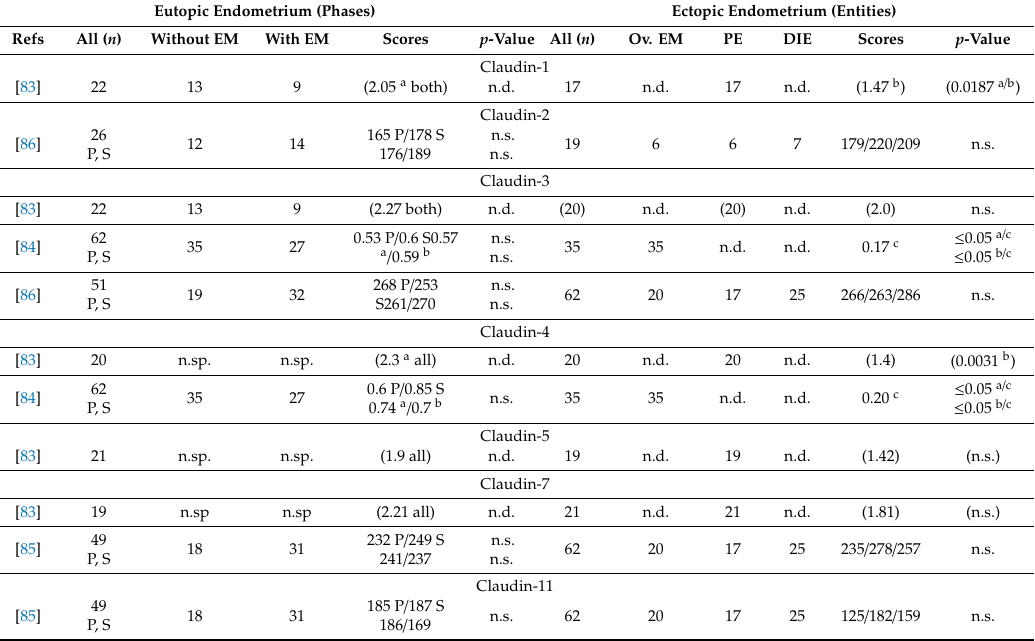
Table 3. Immunohistochemistry of claudins in eutopic and ectopic endometrium. Eutopic Endometrium (Phases)